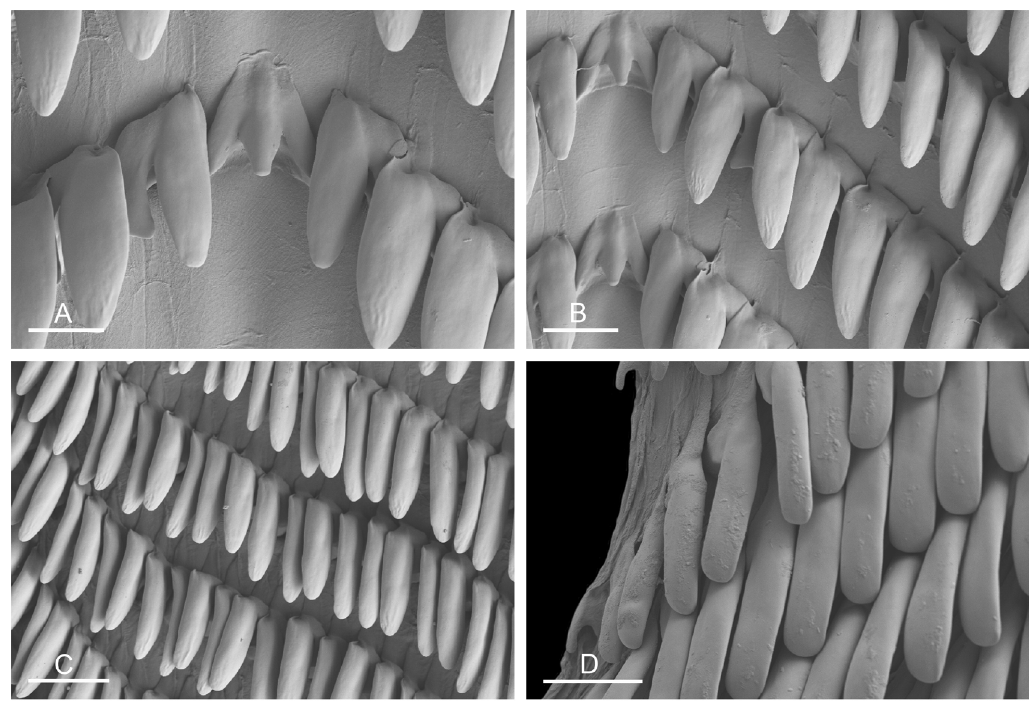
Fig. 35. Paromoionchis boholensis gen. et sp. nov., unit #1, radula, Philippines, Bohol [3372] (PNM 041269) . A . Rachidian and innermost lateral teeth. B . Lateral teeth with rachidian teeth. C . Lateral teeth. D . Outermost lateral teeth. Scales: A = 20 μm; B, D = 30 μm; C = 50 μm.